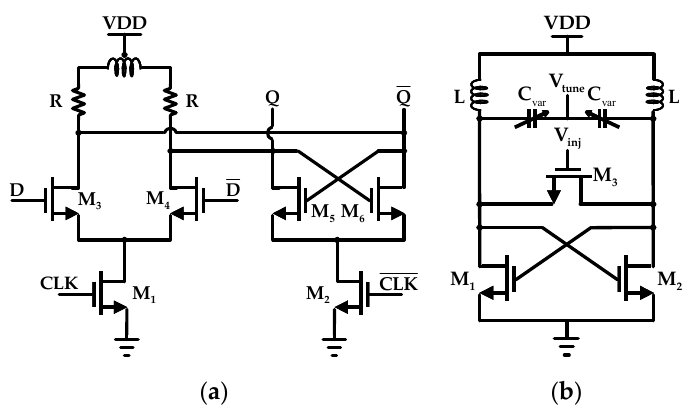
Figure 2. ( a ) A topology of CML divider; ( b ) A topology of